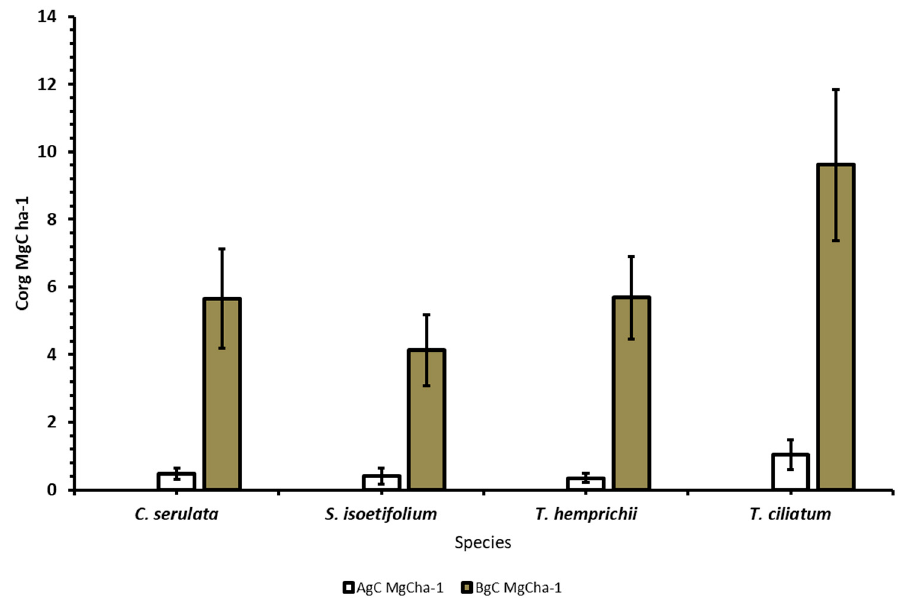
Figure 3. Vegetation aboveground (Agc) and belowground (Bgc) carbon stocks of dominant species reported to a maximum depth of 50 cm. Below ground carbon (Bgc) does not include sediment carbon